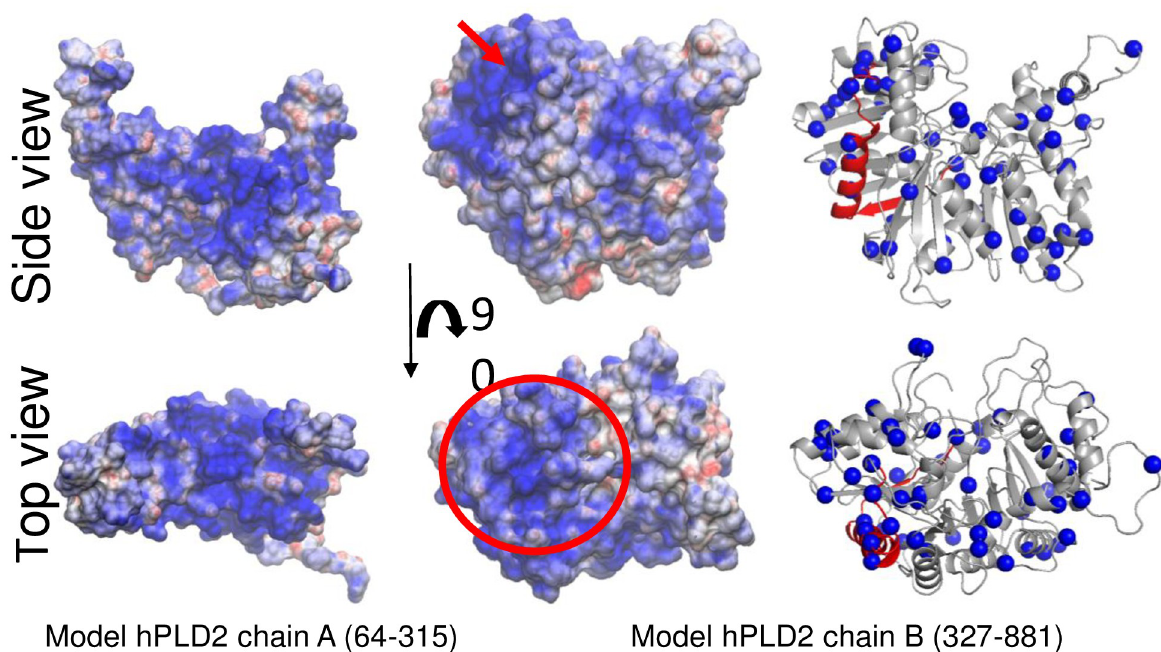
Fig 2. Electrostatic potential analysis. Electrostatic potential mapped on the surface representation of chains A and B of hPLD2. The cluster of positive residues proposed by Sciorra et al [48] to be part of a PIP 2 binding site in chain B is highlighted with a red arrow (side view) and circle (top view). The segment is rendered in red in the ribbon representation of chain B model and the C α of any lysine or arginine are rendered as blue spheres (third column).